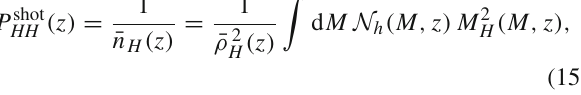
where P gg is given by